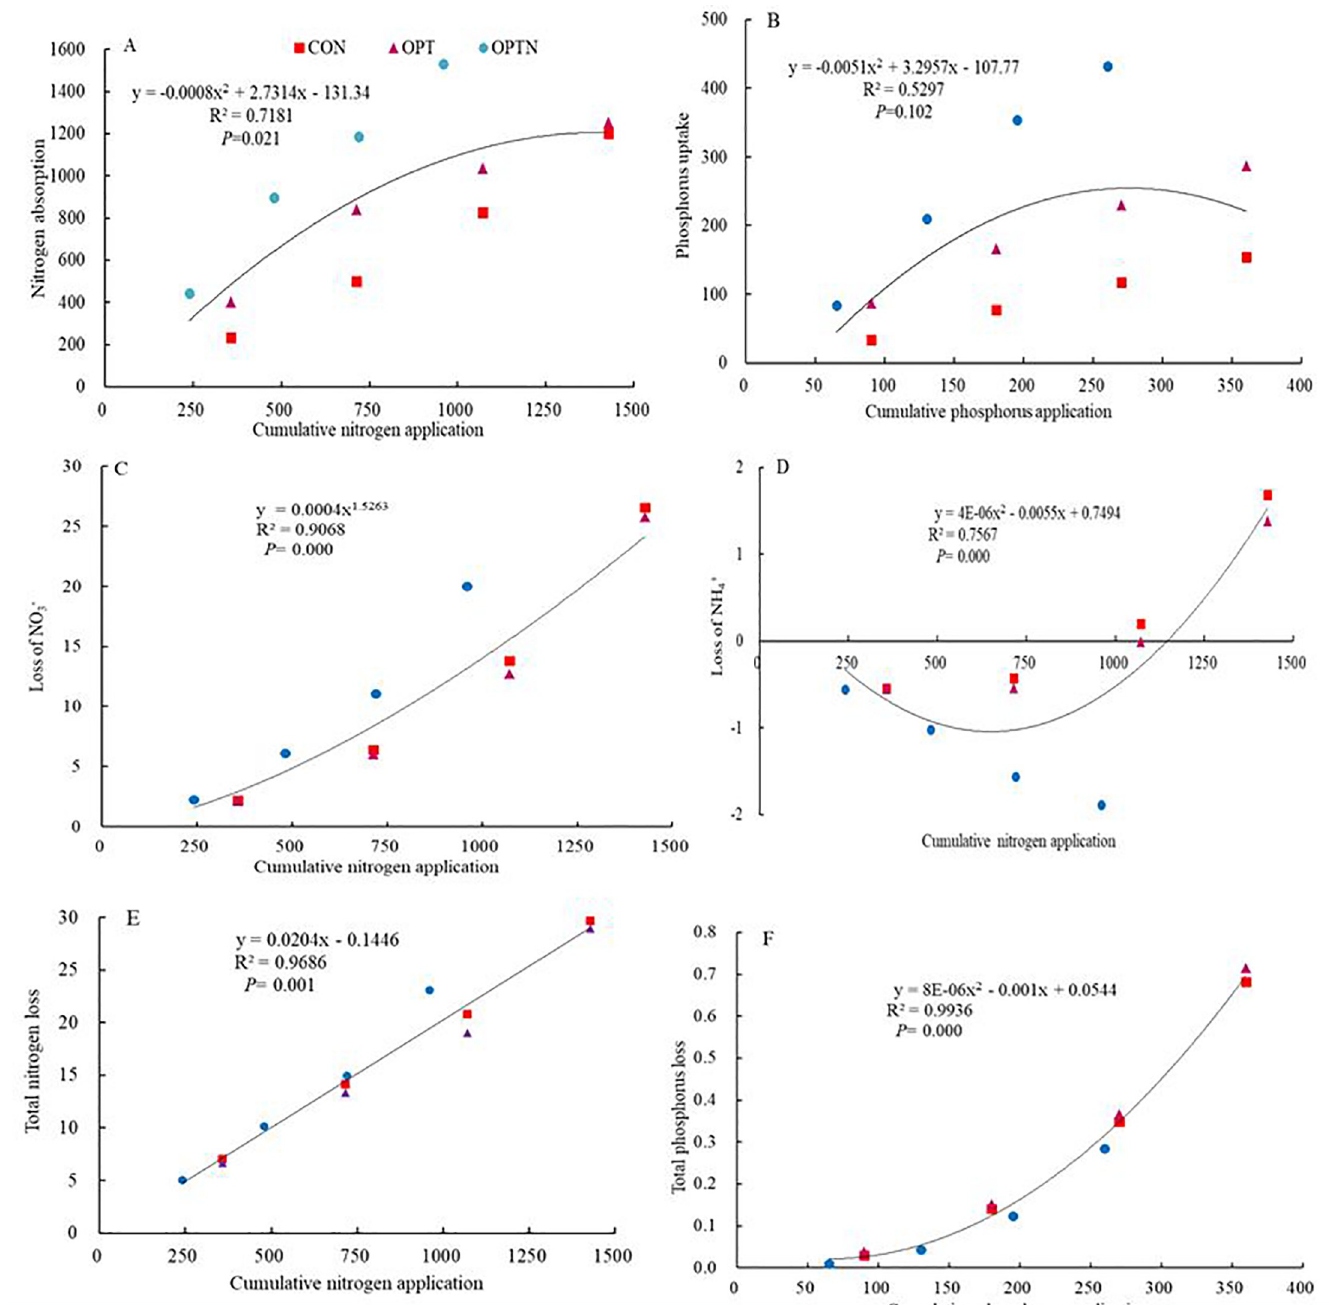
Fig 4. The relationship between nitrogen and phosphorus loss index and nitrogen and phosphorus fertilizer application. The fitting relationship is selected to fit with larger correlation coefficient in the above figure. https://doi.org/10.1371/journal.pone.0249730.g004 different irrigation leaded to the different microenvironment with the same amount of fertili- zation, the soil temperature was higher under less irrigation, so the conversion of NH 4+ to NO 3- was faster, the loss of NO 3- under OPT treatment was higher. The loss of total P under CON and OPTN treatment was higher than other treatment, probably because the amount of